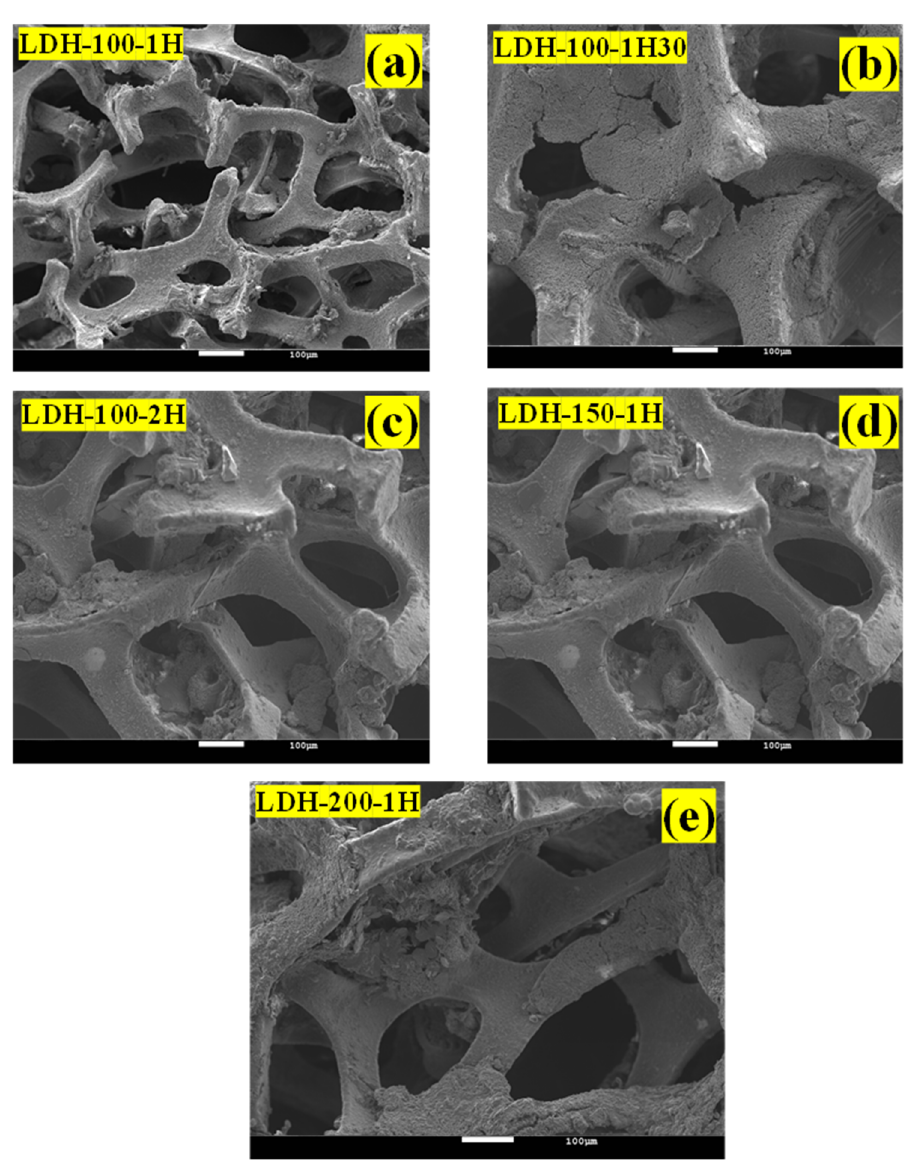
Figure 4. ( a – e ) FESEM images of the LDH-100-1h, LDH-100-1h30, LDH-100-2h, LDH-150-1h, and LDH-200-1h electrodes at a different magnification. Table 1. Mass-loading for all the electrodes.